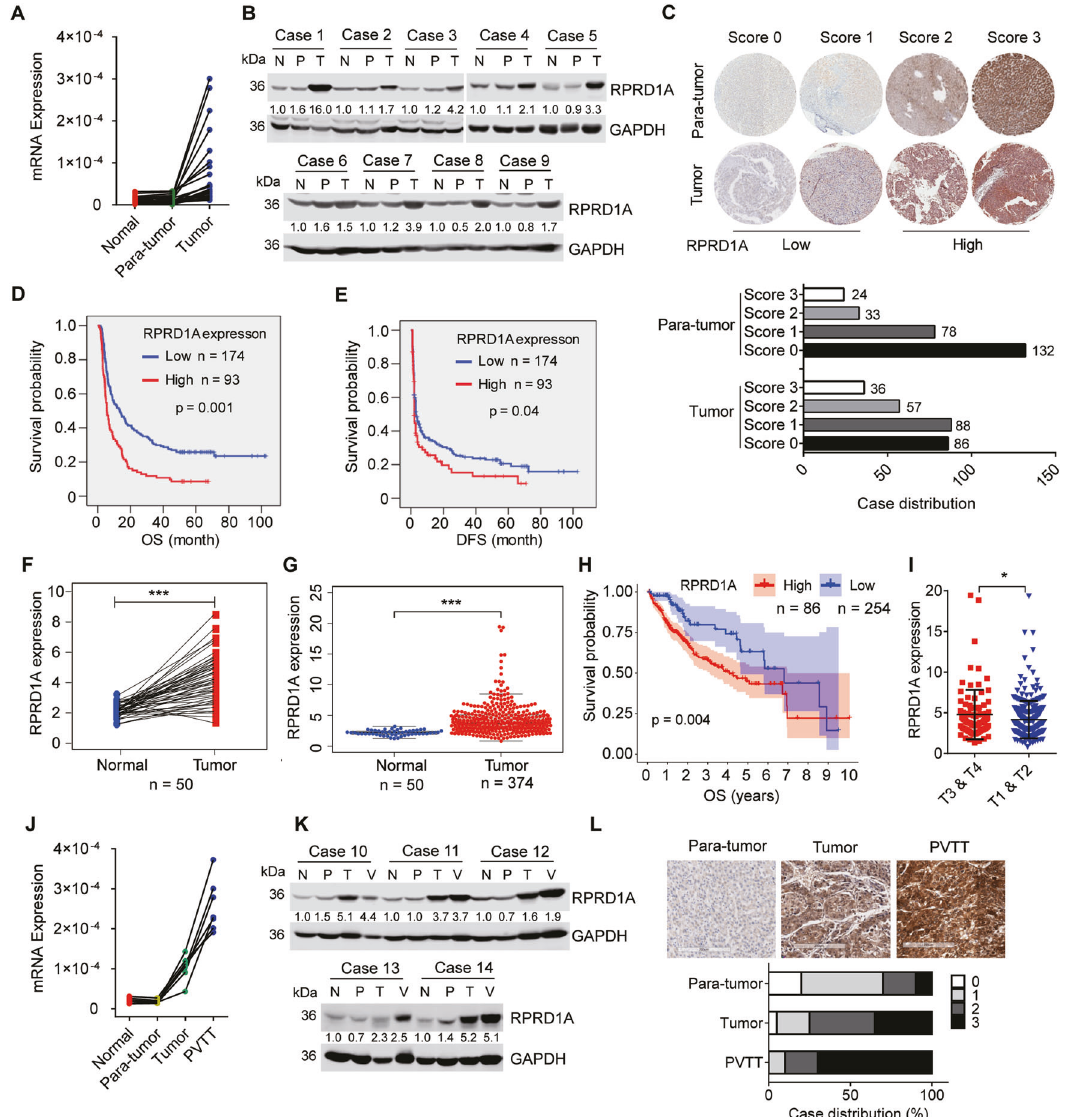
Fig. 1 RPRD1A was overexpressed in HCC samples, and its overexpression correlated with aggressive clinicopathological features. A Real-time PCR (RT-PCR) analysis of RPRD1A mRNA expression in 24 paired primary tumor (T), para-tumor (P), and normal tissues (N) obtained from the Eastern Hepatobiliary Surgery Hospital (EHBH). B Western blotting analysis of RPRD1A protein expression in 9 paired HCC tumor, para- tumor, and normal tissues obtained from the EHBH. C Representative images of RPRD1A staining (score 0, 1, 2, 3) in HCC tissue microarray and the case distribution of different staining scores were shown. D , E ( D ) Overall survival (OS) and ( E ) disease-free survival (DFS) in an HCC cohort obtained from EHBH according to the RPRD1A expression, the log-rank test was used to determine signi fi cance. F RPRD1A expression in 50 paired HCC tumor and normal tissues from the TCGA database. G RPRD1A expression in 374 cases of HCC and 50 cases of normal tissues from the TCGA database. H Overall survival time in an HCC cohort with 343 cases obtained from the TCGA database according to the RPRD1A mRNA expression. I Expression of RPRD1A in tumor T1&T2 and T3&T4 in the database. J – K ( J ) RT-PCR and ( K ) western blotting analysis of RPRD1A in normal liver (N), para-tumor (P), primary tumor (T), and portal vein tumor thrombosis tissues (PVTT). L IHC staining and statistical analysis of the RPRD1A expression (score 0, 1, 2, 3) in PVTT, HCC, and para-tumor tissues. Scale bars, 200 μ m. In panels D , E , H , p values were determined by the log-rank test. In panels F , G , I , the p values were determined by a two-tailed t-test. * p < 0.05, ** p < 0.01, *** p < affect NRF2 protein stability. To evaluate this hypothesis, we translocator (ANT), NAD(P)H quinone oxidoreductase l (NQO1), treated HCC cells with the protein synthesis inhibitor, cyclohex- heme oxygenase 1 (HO1), peroxiredoxin 4 (PRDX4) and peroxir- imide (CHX). As expected, the NRF2 protein level gradually edoxin 6 (PRDX6) were positively regulated by RPRD1A (Fig. 4C, D), decreased in control cells after CHX treatment in a time- as well the protein level of GCLC, GCLM and NQO1 (Fig. 4E). As dependent manner; however, RPRD1A overexpression markedly most of these genes are transcriptional targets of NRF2 (MacLeod attenuated while RPRD1A knockdown accelerated the degrada- et al., 2009), and NRF2 protein could be affected by RPRD1A under tion of NRF2 (Fig. 4H). We then analyzed the ubiquitination status H 2 O 2 treatment (Fig. 3J). We further investigate the relationship of NRF2 in RPRD1A differentially expressed cells. The poly- between RPRD1A and NRF2. Real-time PCR and western blotting ubiquitination of NRF2 increased in RPRD1A-interfered cells (Fig. assays revealed that RPRD1A regulated NRF2 at the protein level, 4I), while decreased in RPRD1A-overexpressed cells (Fig. 4J). but not the RNA level (Fig. 4F, G), suggesting that RPRD1A may